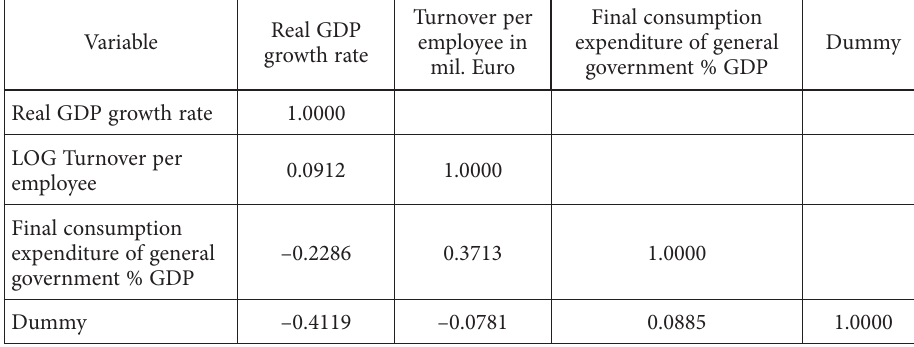
Table 2. Correlation matrix between independent variable and predictors (source: authors’ calculations)